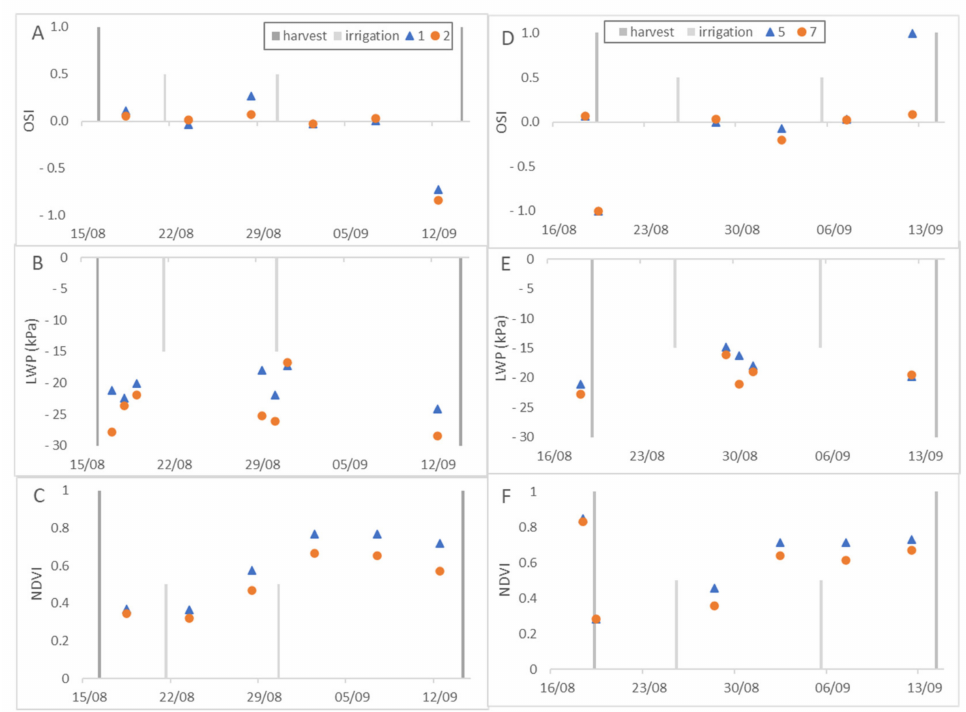
Figure 9. The spectral data and crop measurements for sites 1, 2 ( A – C ), and 5, 7 ( D – F ), the seventh growth cycle.